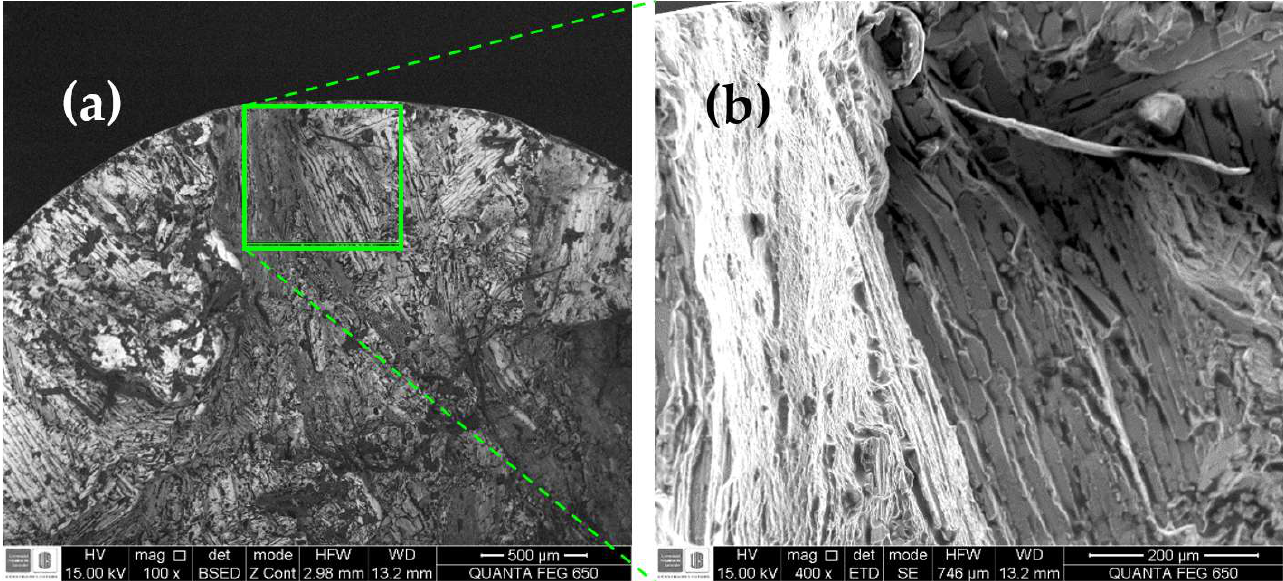
Figure 14. SEM micrographs showing the slipping planes: ( a ) a general view; ( b ) a